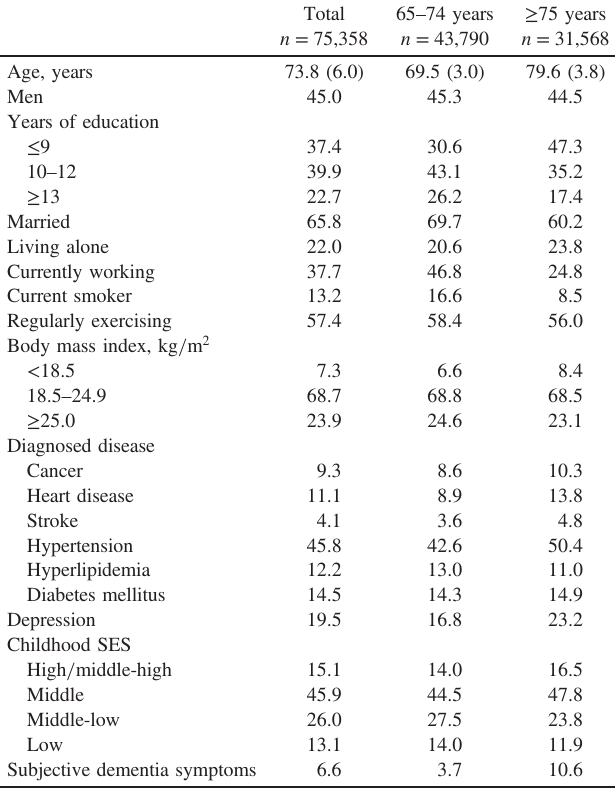
Table 1. Participant